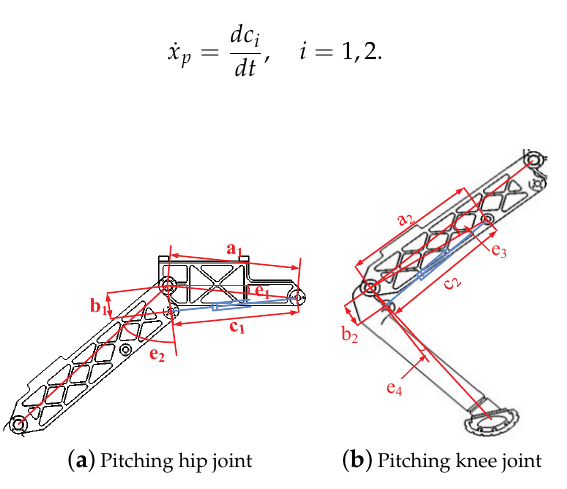
Figure 6. Mechanical structure parameters of the leg. Table 2. Mechanical parameters used in Figure